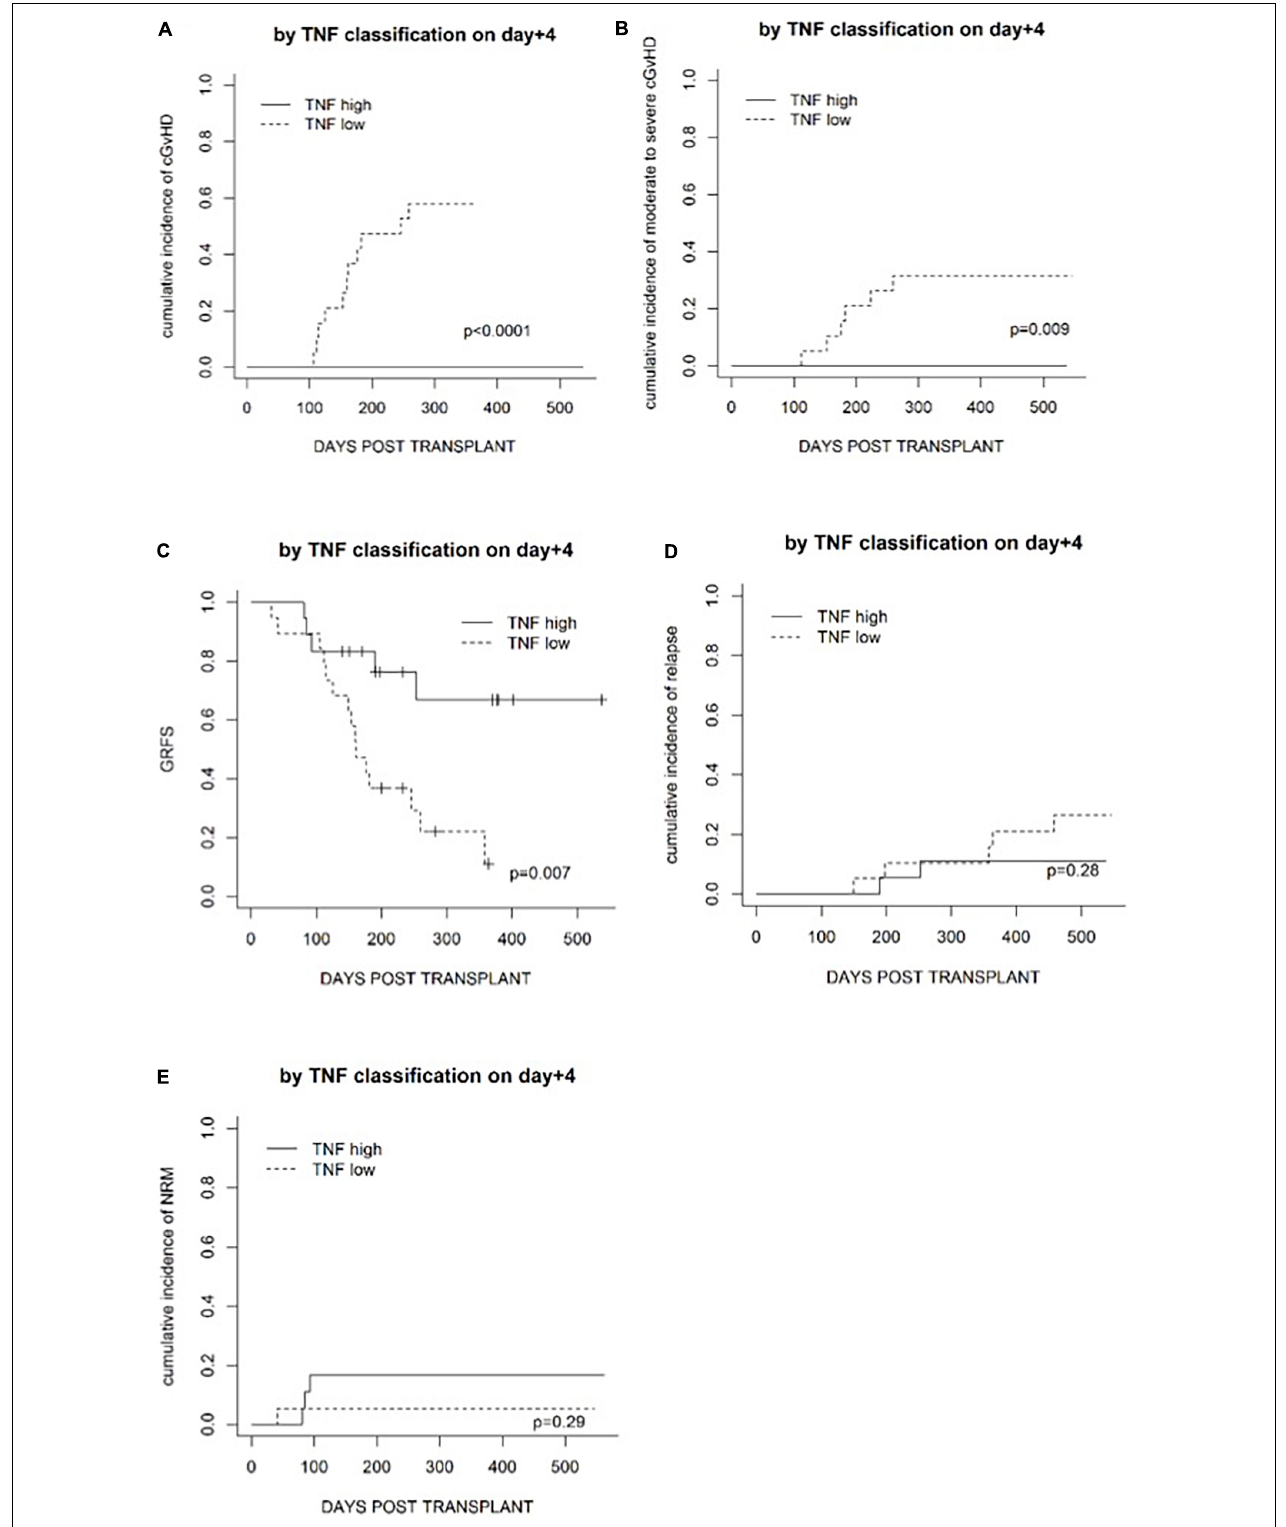
FIGURE 3 | Transplantation outcomes in patients in a TNF-high group and a TNF-low group based on the median level on day +4. (A) The cumulative incidence of cGvHD. (B) The cumulative incidence of moderate to severe cGvHD. (C) GvHD and relapse-free survival (GRFS). (D) The cumulative incidence of relapse. (E) The cumulative incidence of non-relapse